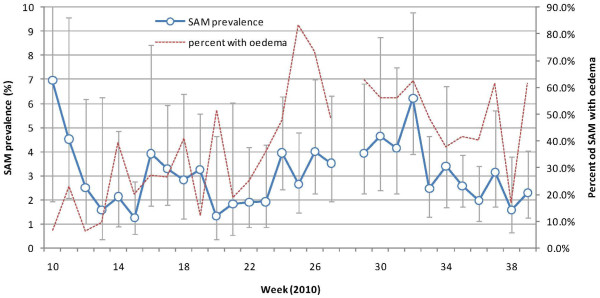
Prevalence of SAM (according to MUAC and/or edema; vertical bars represent 95% CIs) and percentage of SAM cases with edema, by week, 2010.